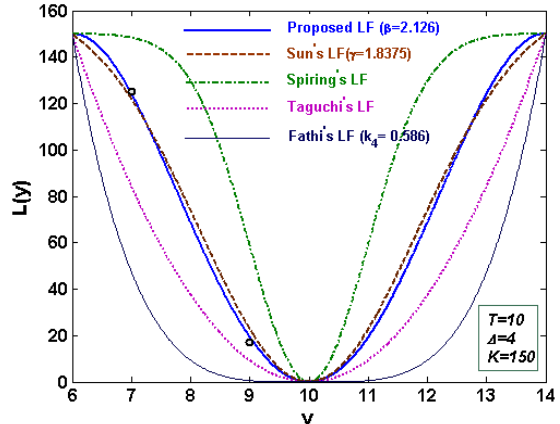
Figure 8. Comparison of the proposed PLF with some known LFs drawn for the same